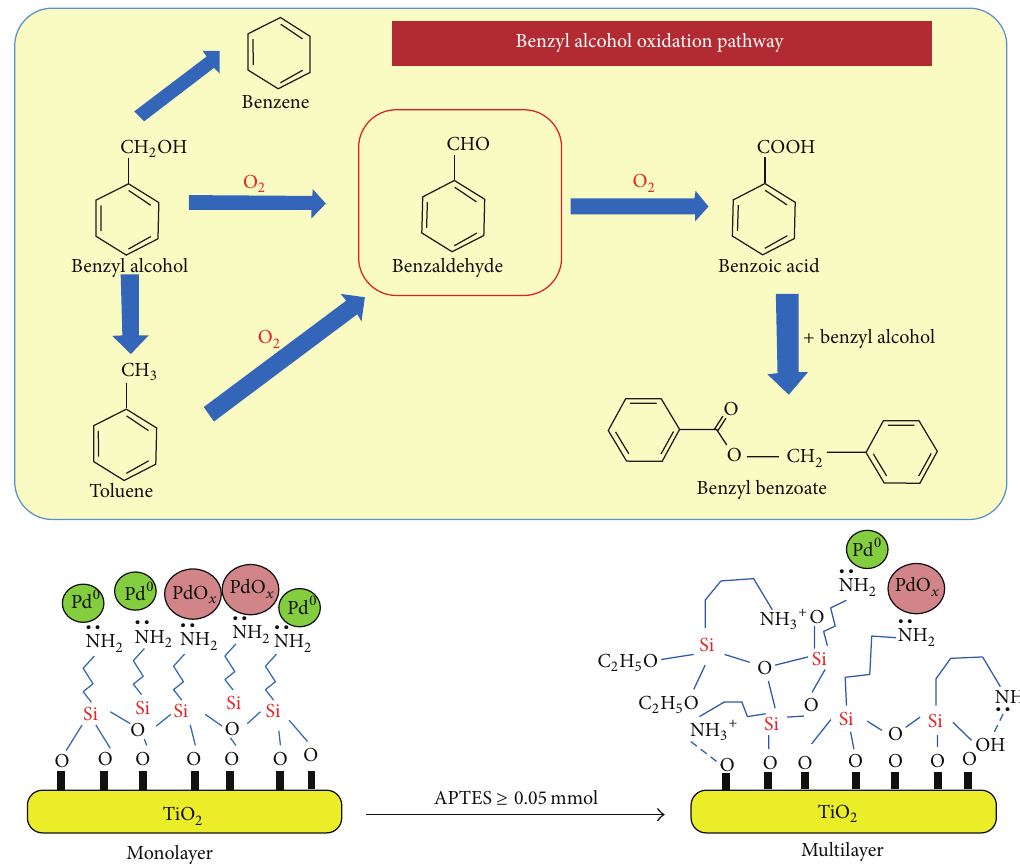
Figure 6: Surface functionalized TiO 2 supported Pd catalysts for solvent-free selective oxidation of benzyl alcohol